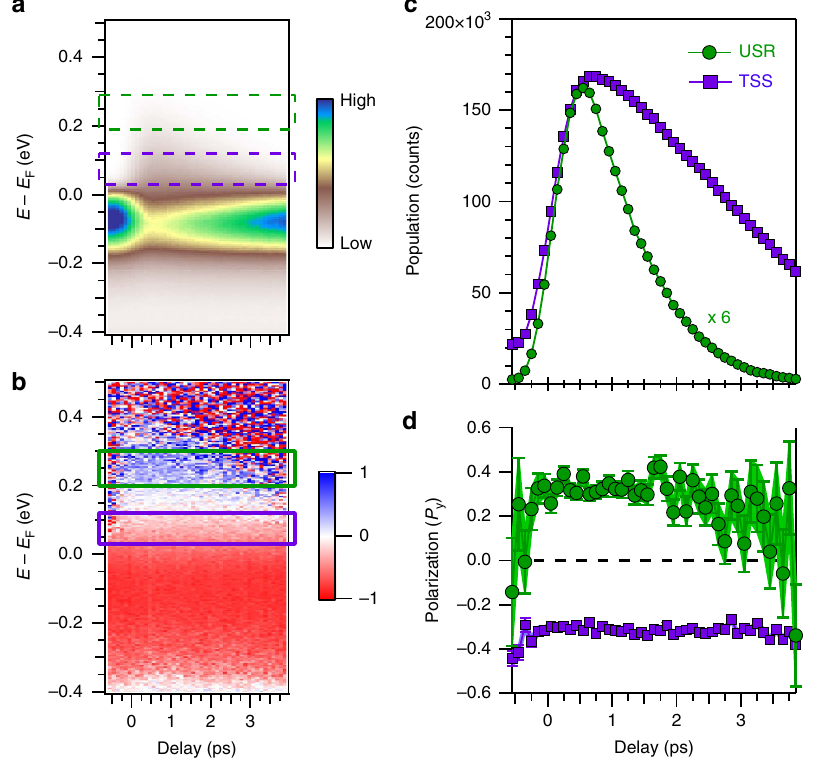
Figure 3 | Time independence of the spin polarization. ( a ) The spin-integrated spectrum plotted versus pump-probe delay and ( b ) its corresponding spin-polarization. The time dependence is obtained by changing the delay between the arrival of the pump and probe pulses on the sample surface. Two energy regions corresponding to the unoccupied surface resonance (USR) and topological surface state (TSS) are demarcated with boxes. The colorscales represent photoemission intensity and spin-polarization, respectively. ( c ) Photoemission intensity obtained by integrating within the boxes for the USR and TSS, showing a substantial increase in population from the pump excitation. ( d ) The delay-dependent spin polarization of both regions, which is constant within statistical error